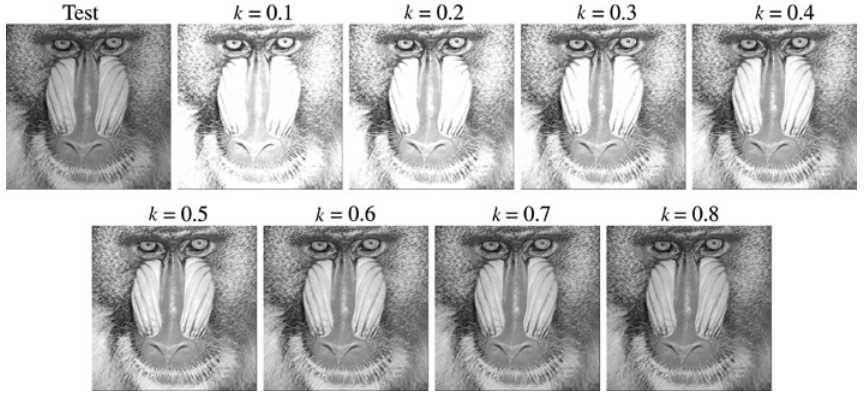
Figure 2: Images Obtained after Convolving the Test Image with the Fractional Mask of Order k